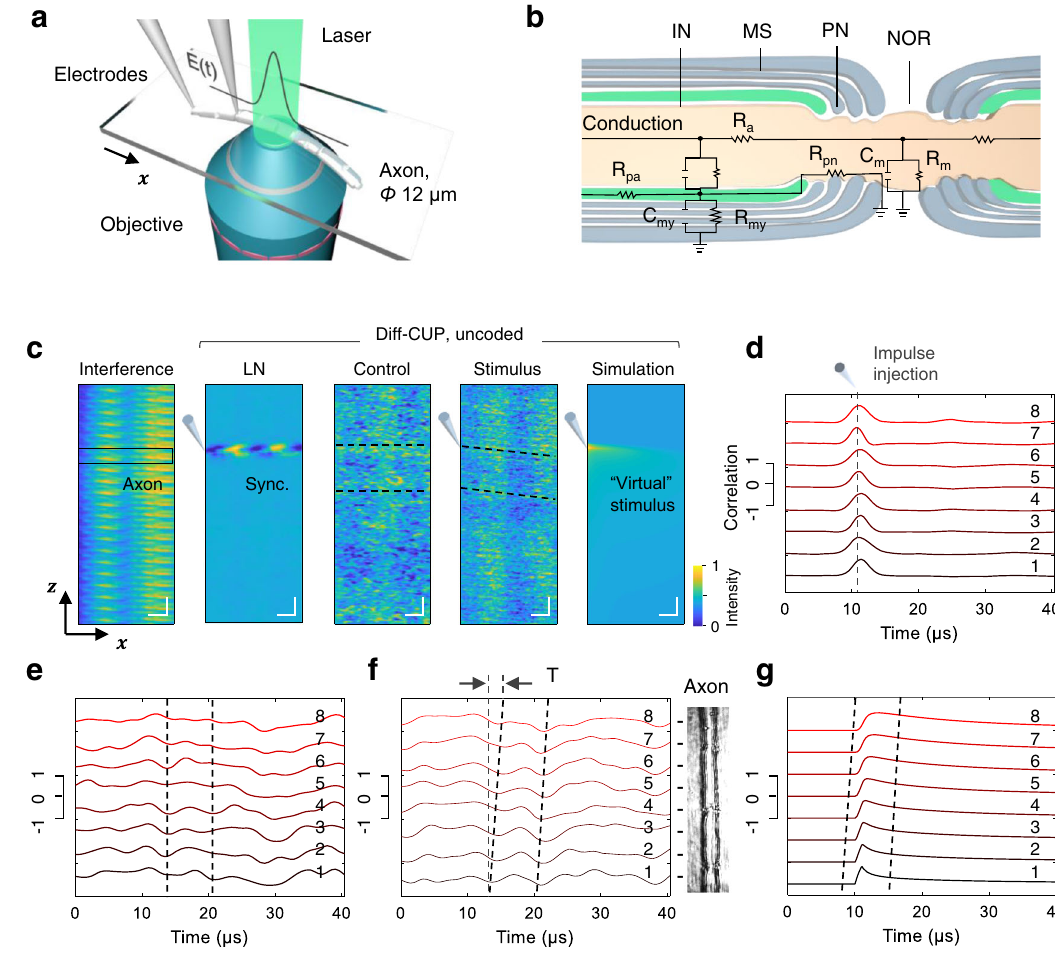
Fig. 3 | Uncoded Diff-CUP imaging of propagating internodal current fl ows in myelinatedaxons.a Setupforimagingpropagatinginternodalcurrent fl owsinthe sample arm of Diff-CUP ’ s Mach – Zehnder interferometer. E ð t Þ is the transient fi eld stimulation applied to the parallel bipolar microelectrodes. b Schematic of the equivalentdoublecableinternodalcircuit.INinternode,PNparanode,NORnodeof Ranvier, MS myelin sheath; R a , axonal axial resistivity; R pa , periaxonal resistivity; R pn , paranodal resistivity; R m and C m , speci fi c membrane resistance and capaci- tance; R my and C my , speci fi c myelin sheath resistance and capacitance. c , Spatiotemporal interferograms of a propagating internodal current fl ow in a myelinated axon captured by uncoded Diff-CUP (400 interferograms) under dif- ferent conditions. The horizontal and vertical axes of the interferogram denote x and z , respectively, where z = nd + y , x and y are the two spatial axes, n stands for the n -th axon image in the time series, and d denotes the FOV in the y dimension. From left to right: interference, unprocessed interferogram; LN, interferogram captured with a synchronous EMP induced in the LN crystal, where the strong